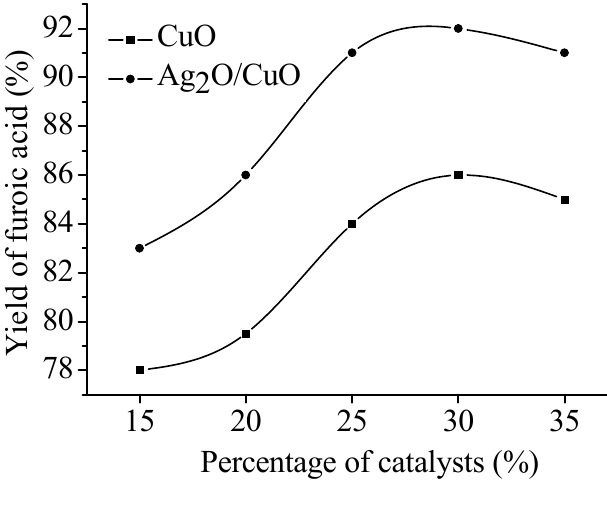
Figure 3. Effect of catalyst amount on furoic acid